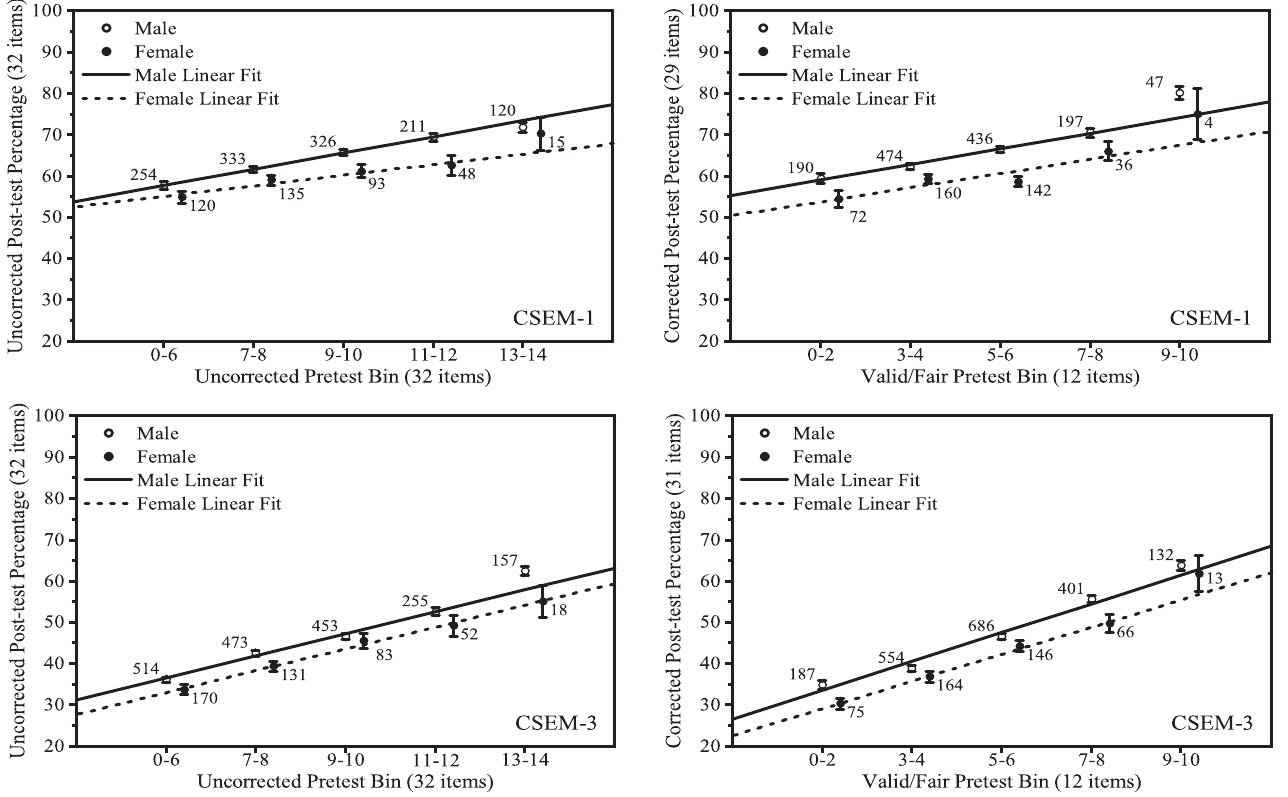
FIG. 2. Post-test vs pretest. Average CSEM pretest and post-test percentage scores on the uncorrected (left column) and corrected (right column) instrument. Linear fits only included bins containing greater than 30 students.